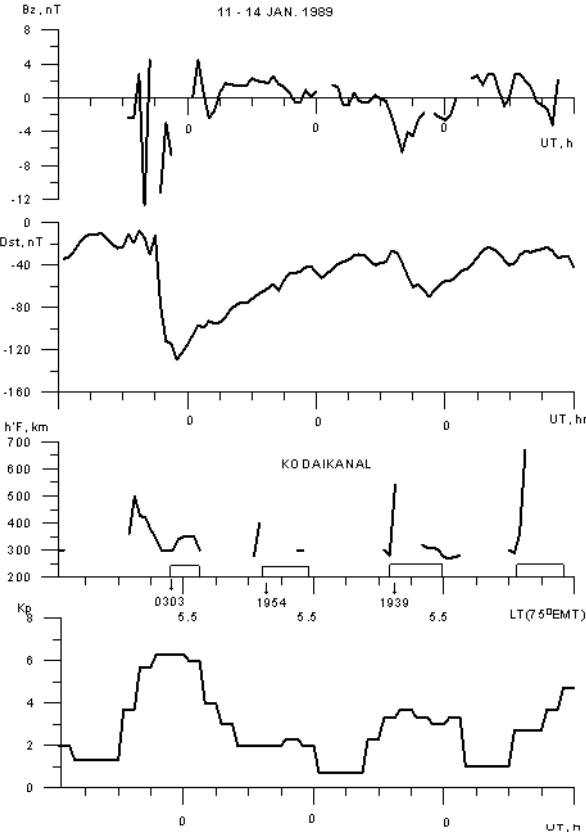
Fig. 4. Storm 4: 11–14 January 1989, (Category 2). The upper two panels show the IMF B z and D st variations. The lower two panels show the ionospheric F -layer height h 0 F at Kodaikanal and the K p index. The times and durations of scintillation activity are marked by the rectangles along the time axis of the h 0 F